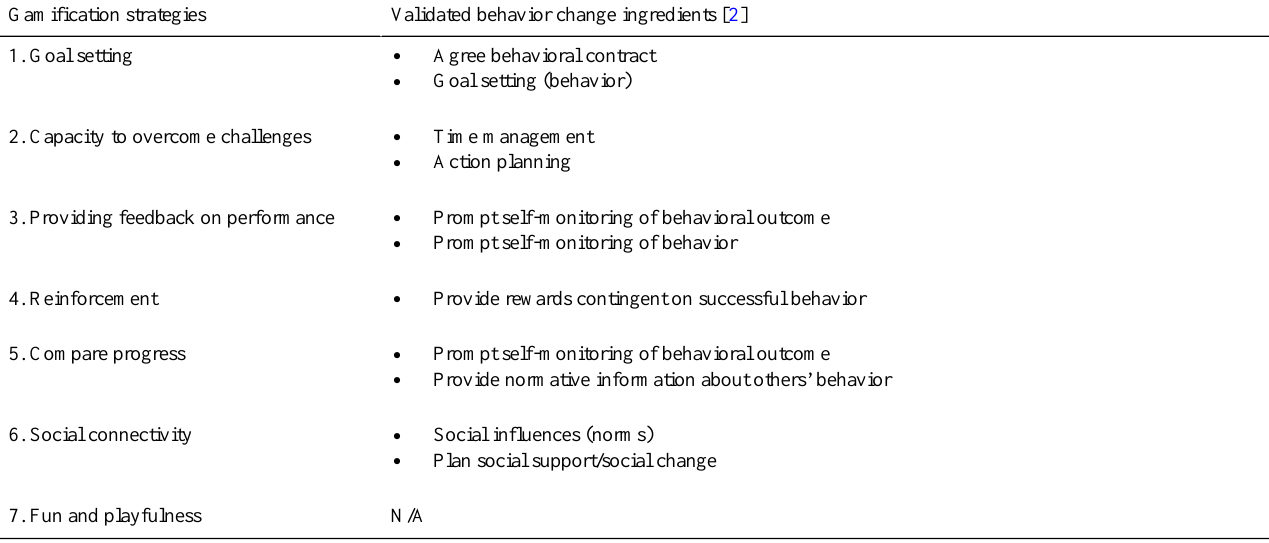
Table 1. Gamification strategies and validated behavior change